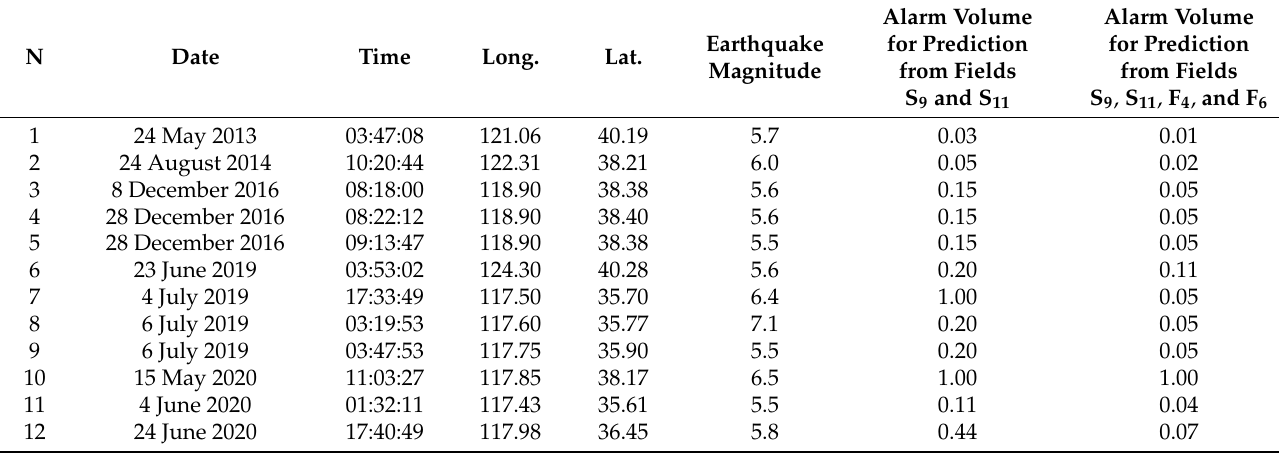
Table 7. California. Results of forecasting earthquakes with magnitudes m ≥ 5.5 from seismological fields and from the same fields together with GPS